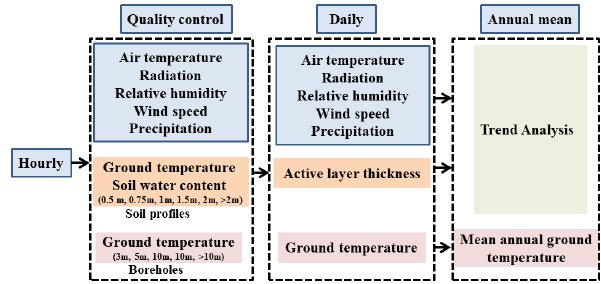
Figure 4. Schematic diagram of data processing workflow used to compile the permafrost dataset on the QTP. Table 2. Information for the six meteorological stations. Sites XDT TGL LDH ZNH AYK TSH Elevation (ma.s.l.)